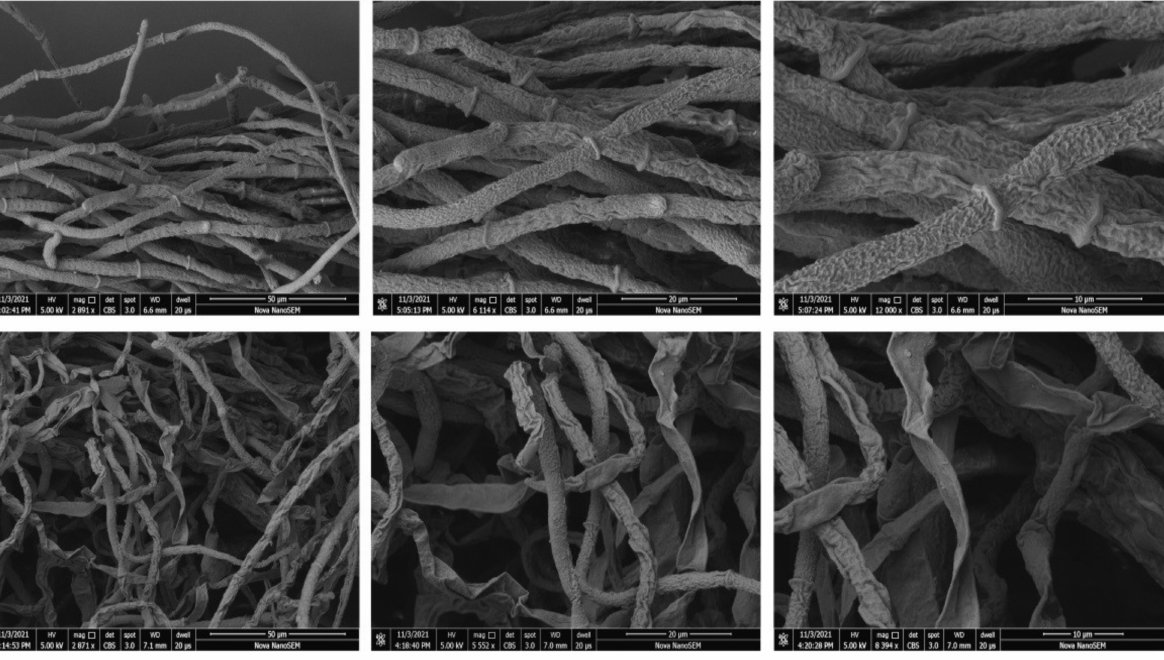
Figure 5. Scanning electron micrographs of S. sclerotiorum hyphae in untreated control ( A ) and treated with compound F15 ( B ) at 50 µ g/mL.